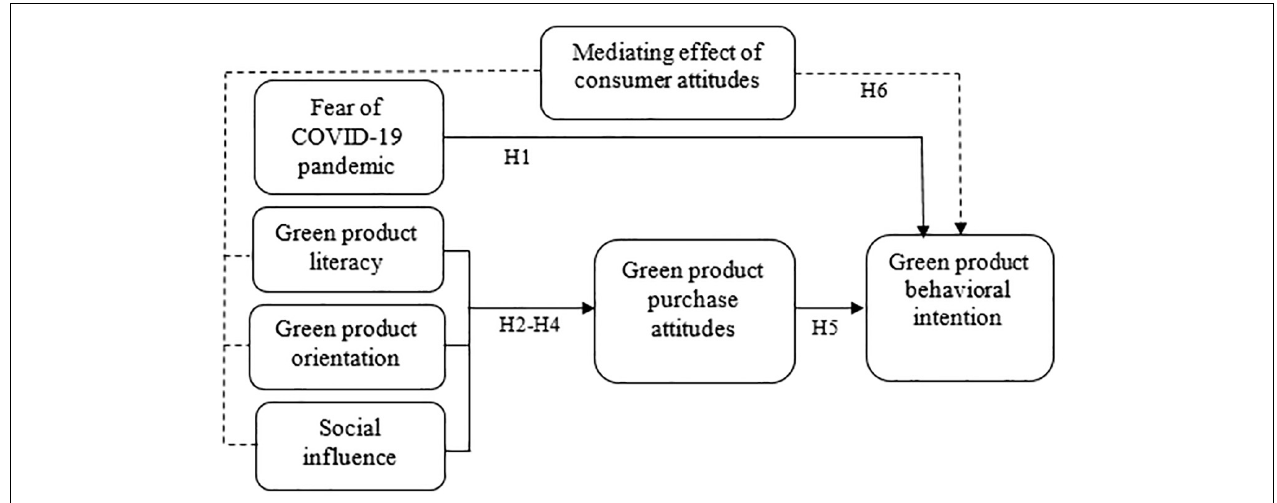
FIGURE 1 | Conceptual